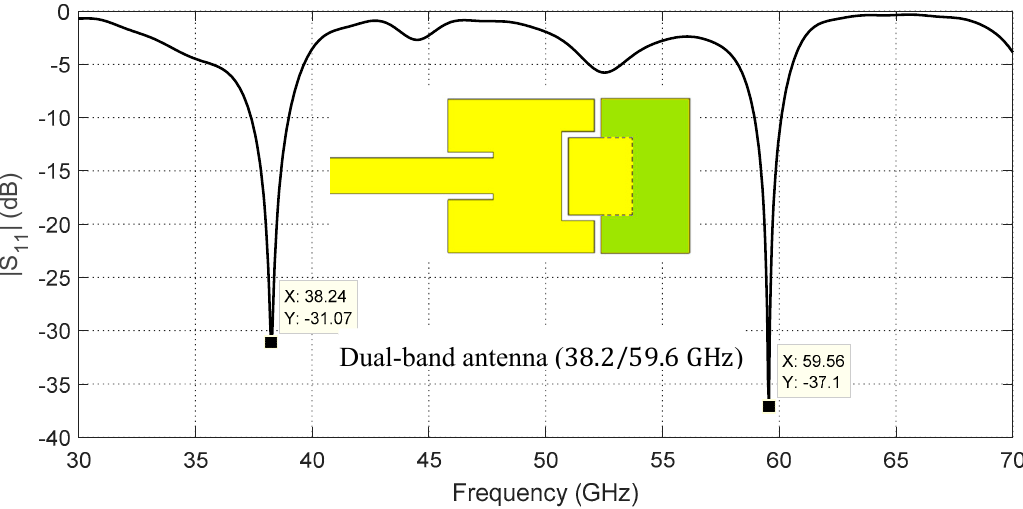
Figure 4. Simulated dependence of the return loss, | S 11 | , on the frequency over a wide band of the frequency for the indicated dual-patch antenna (intermediate stage for the final design).